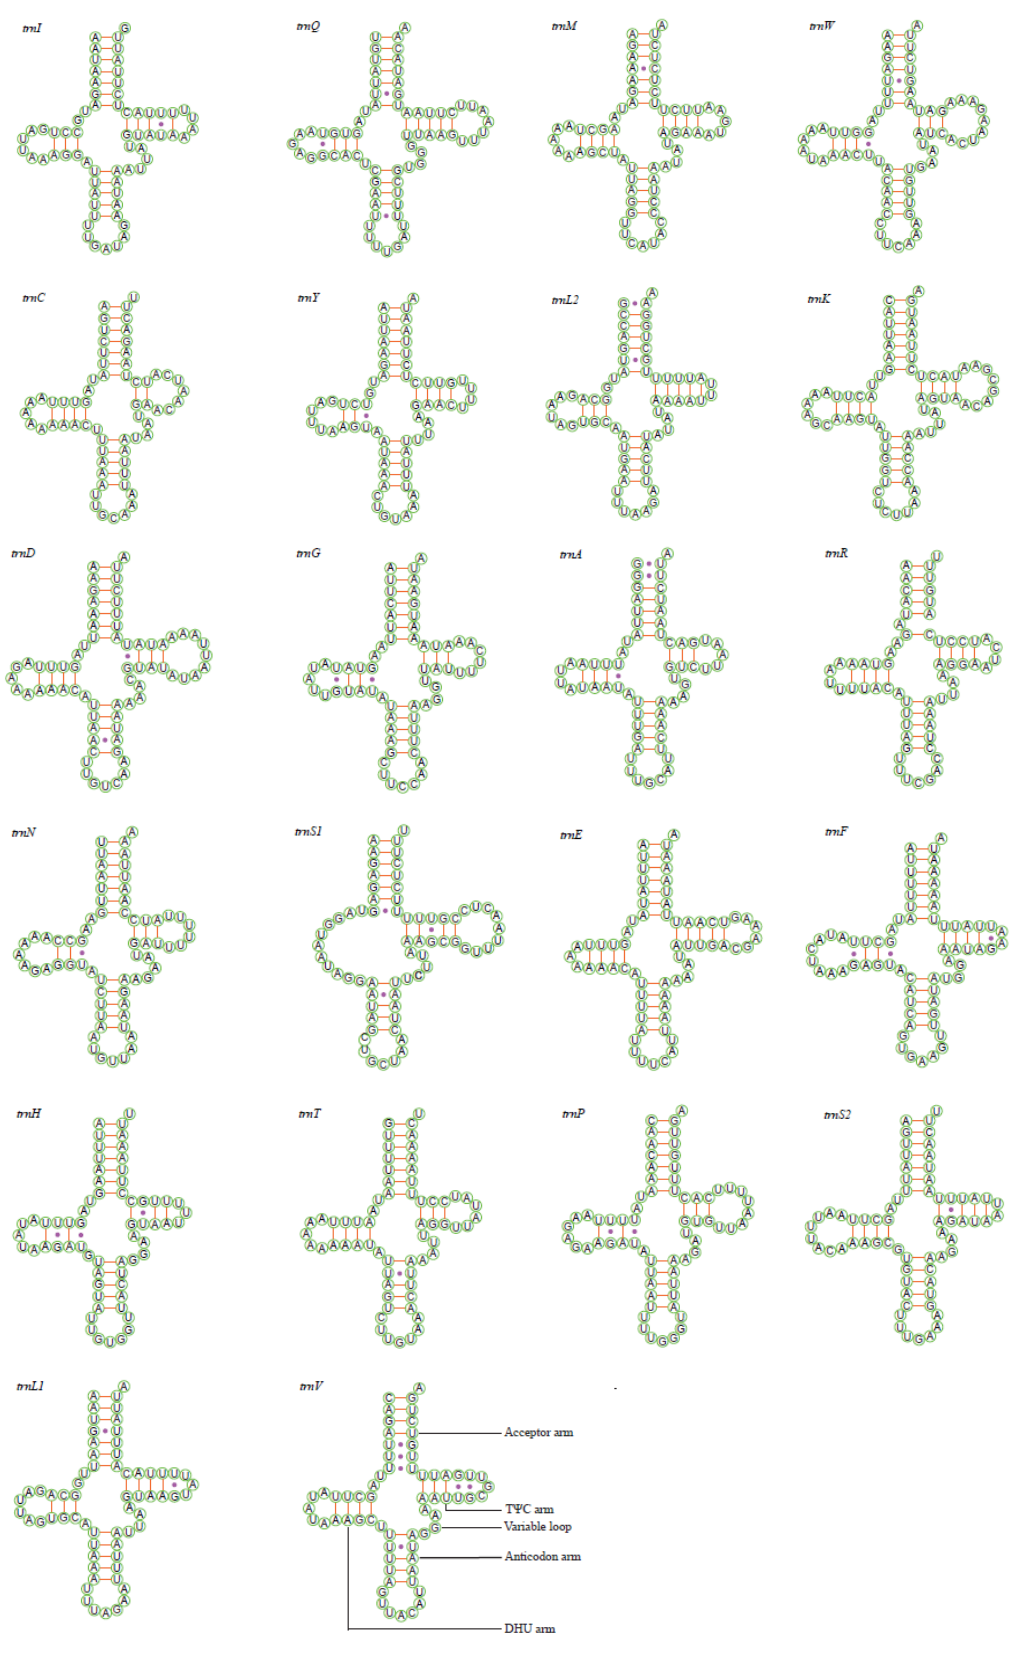
Figure 3. Predicted cloverleaf secondary structure for the 22 tRNAs of Drabescus ineffectus .